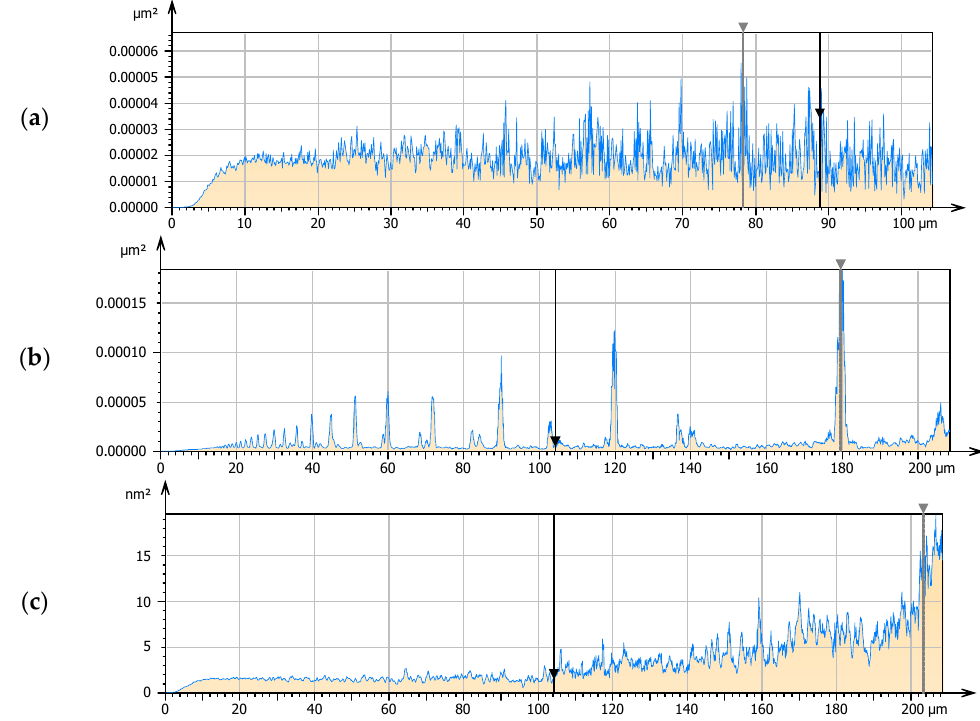
Figure 14. Average power spectral density of surfaces: base no. 1 ( a ), modified no. 2 ( b ) and modified no. 3 ( c ).